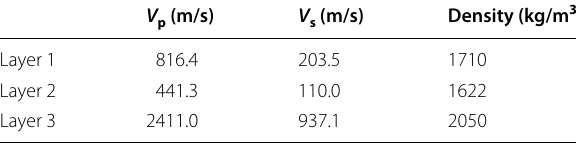
Table 2 Velocity model used for 3-D SEM calculation